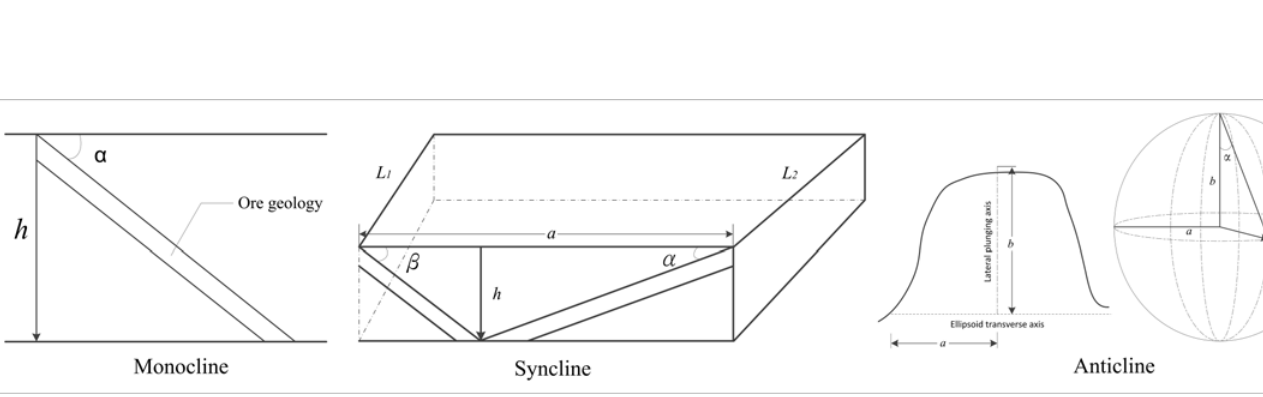
Fig 14. Process of GIS cloud-computing service for iron mine potential evaluation.